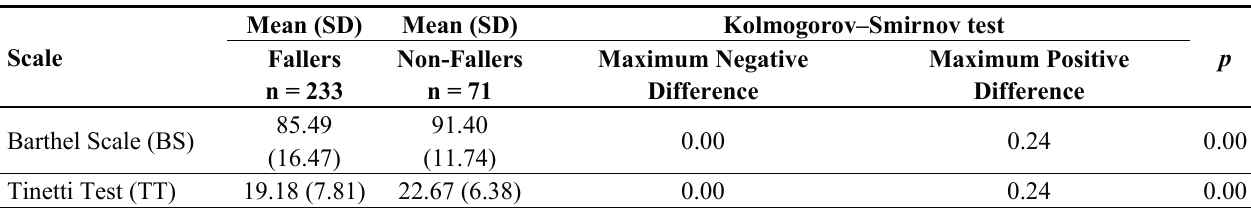
Table 1. Barthel Scale (BS) and Tinetti Test (TT) results depending on fall incidence (Kolmogorov-Smirnov test).